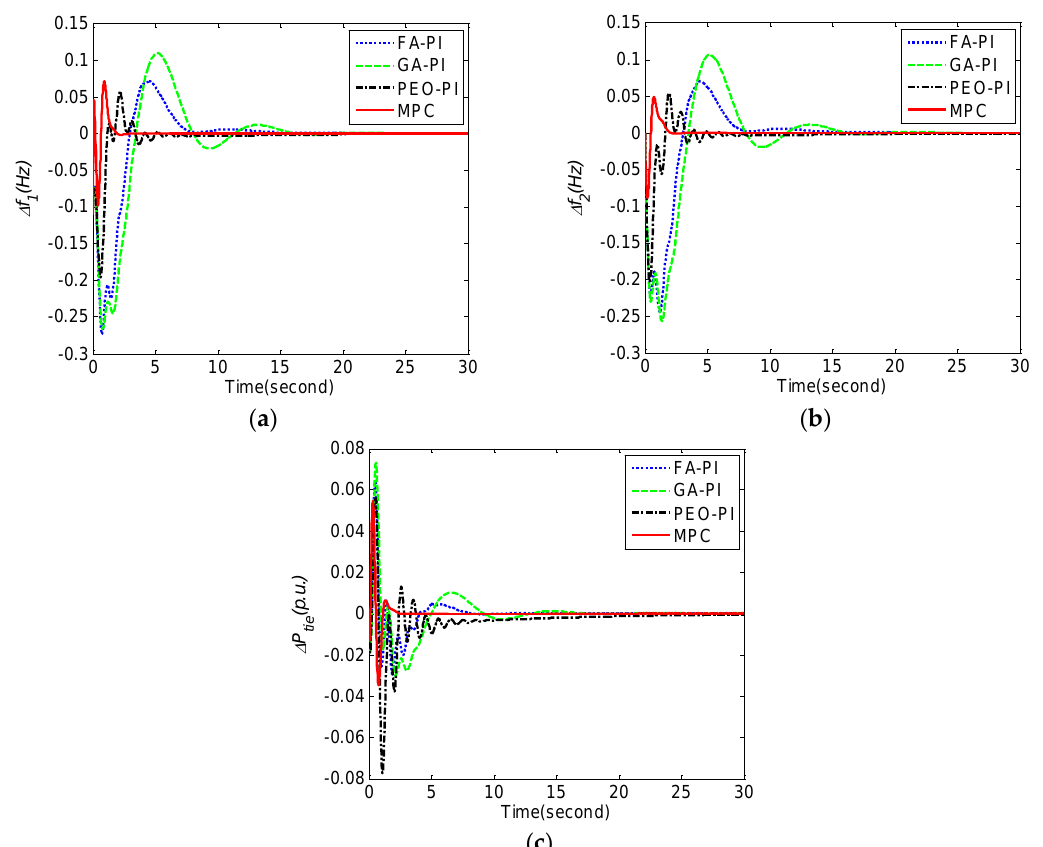
Figure 5. Comparison of frequency deviations ∆ f 1 , ∆ f 2 , and tie line power deviation ∆ P tie obtained by different control methods for case 2. ( a ) frequency deviation ∆ f 1 ; ( b ) frequency deviation ∆ f 2 ; ( c ) tie line power deviation ∆ P tie .